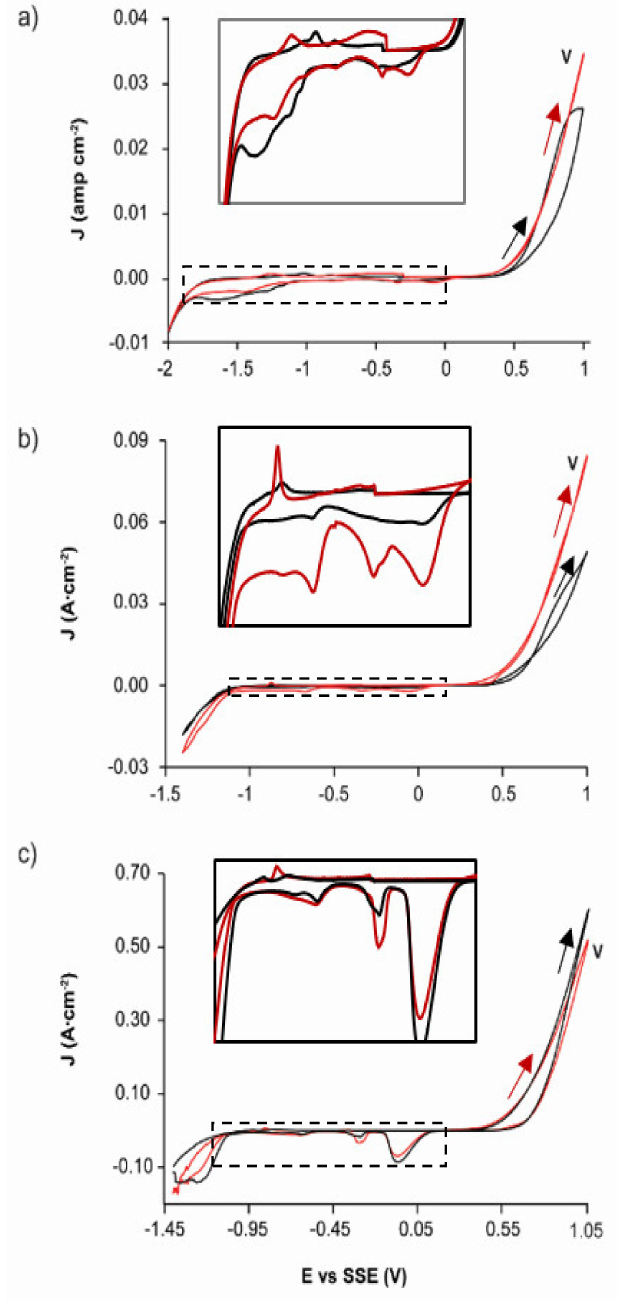
Figure 2. Typical CPE-ZnS voltamperograms (70:30 wt.%) obtained at a scan speed of 100 mVs − 1 and positive direction. ( a ) 0.1 M Na 2 SO 4 , pH = 7; ( b ) 0.1 M H 2 SO 4 , pH = 2; ( c ) 1.7 M H 2 SO 4 . Red line indicates EAHSS with 10 wt.% pyrite; black lines, EBHSS. Full line squares show the detailed redox processes of the samples indicated in dashed